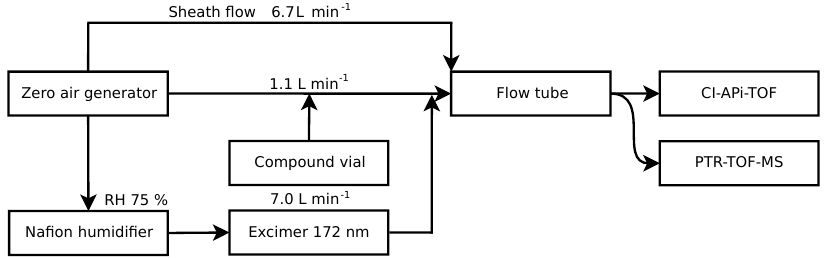
Figure 1. Experimental setup. Zero air from a pure-air generator is split into three flows. There is a sheath flow of 6.7Lmin − 1 . An airstream of 1.1Lmin − 1 collects vapors from a reagent compound vial and is then mixed with a humidified airstream of 7Lmin − 1 (RH 75%) which carries OH free radicals generated through irradiation at 172nm. Table 1. Initial concentrations of precursors, reaction rate coefficients, ArHC reacted fraction (%), total HOM concentration, and HOM yield (%) relative to the reacted ArHC. The concentration of precursors was determined at the exit of the flow tube when the excimer lamp (OH generation) was switched